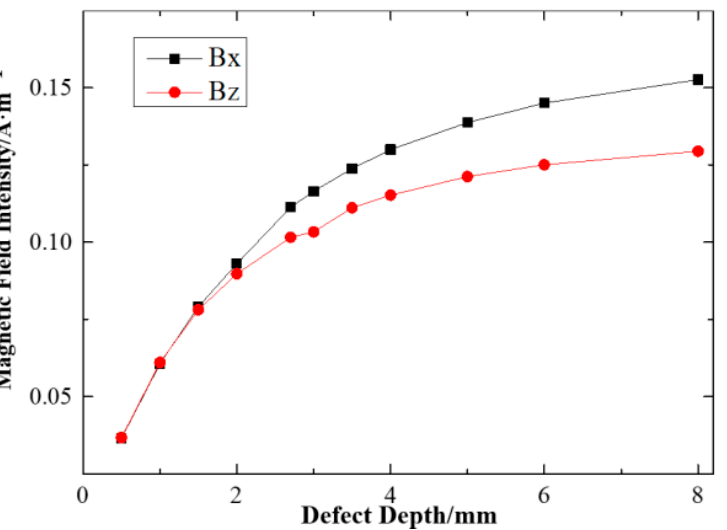
Figure 8. Peak-to-peak fi tt ing curve in Bx and Bz directions.